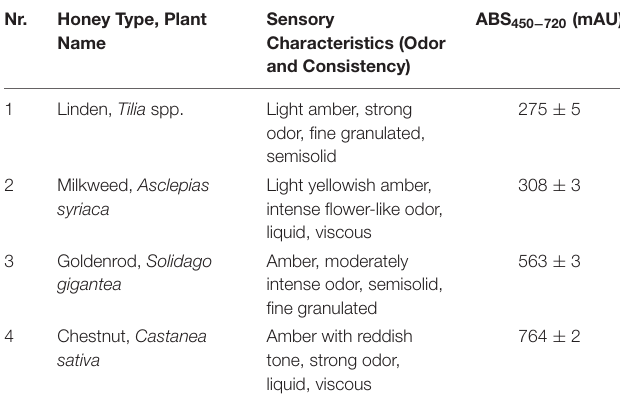
TABLE 1 | Sensory characteristics and color of analyzed honey samples.